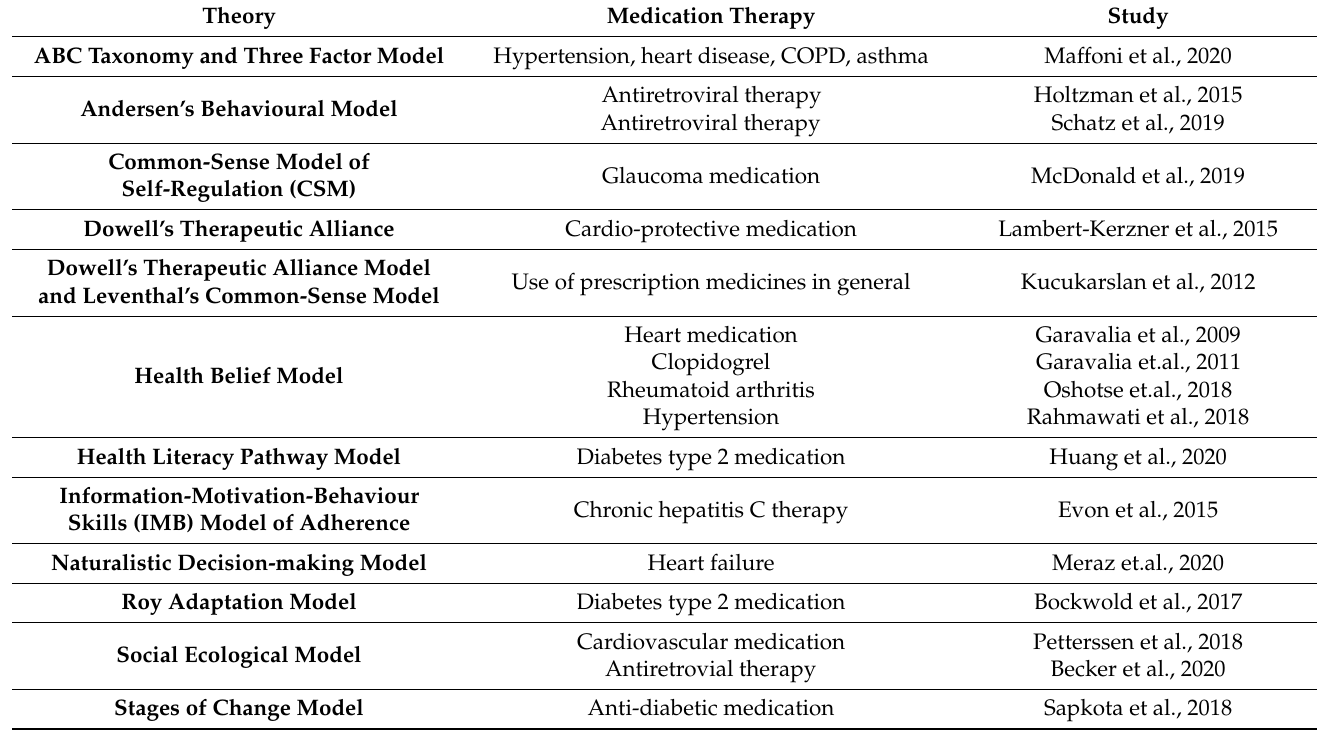
Table 1. Summary of the theories used in the included studies.